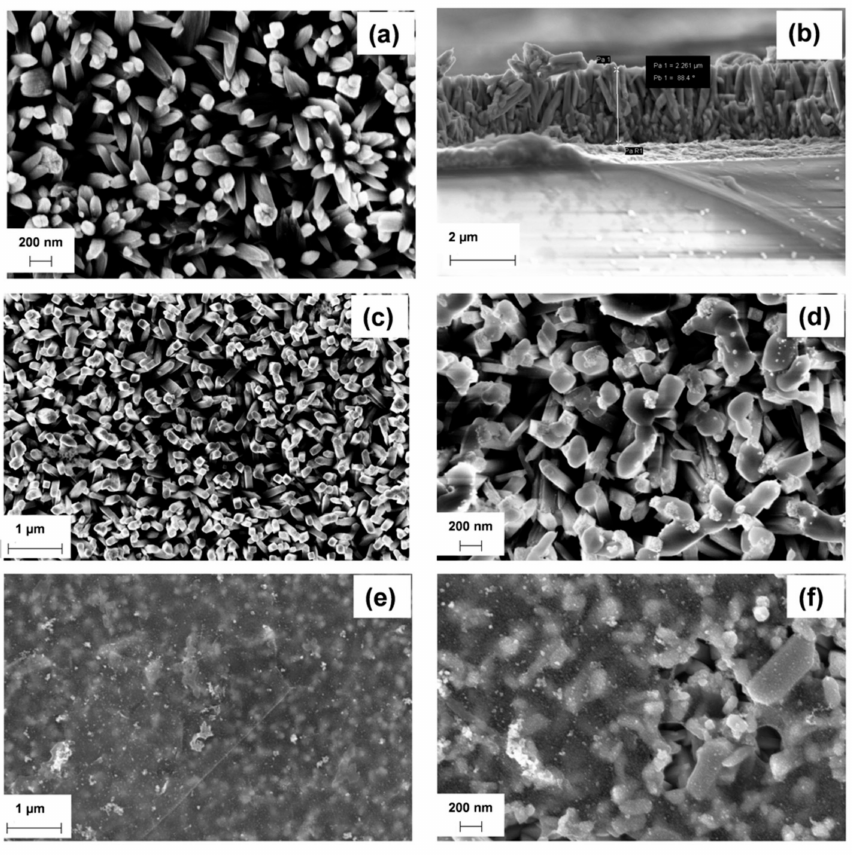
Figure 2. Scanning electron microscope (SEM) images of: TiO 2 nanorods (NRs) on fluorine doped tin oxide (FTO) ( a ); cross-section of TiO 2 NRs ( b ); β -Cu 2 V 2 O 7 /TiO 2 ( c , d ); r-GO/ β -Cu 2 V 2 O 7 /TiO 2 ( e , f